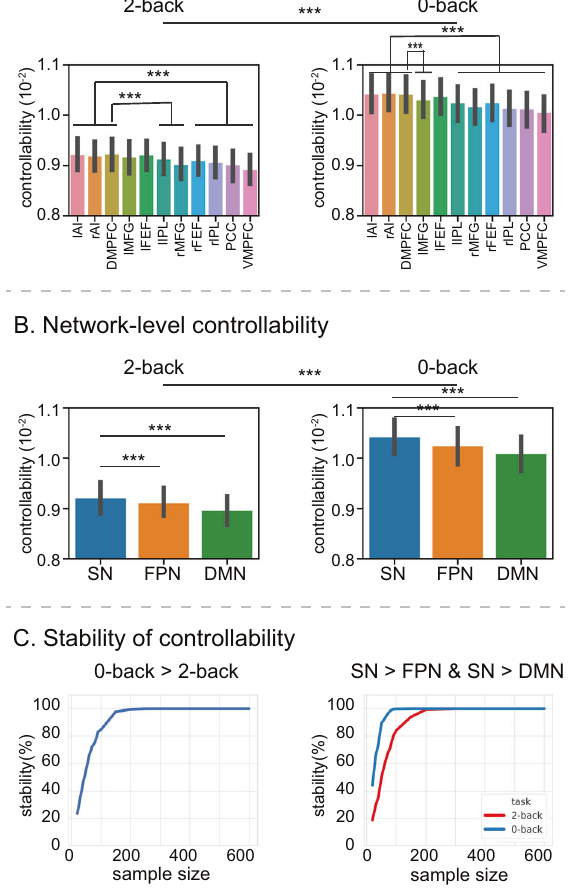
Fig. 7 Working-memory load-dependent functional controllability in SN, FPN, and DMN. A Functional network controllability, assessed in each brain node, was signi fi cantly lower in the 2-back, compared to the 0-back, working-memory task condition ( p < 0.001, two-sided t -test). n = 737 participants. Data are presented as mean ± SEM. AI and DMPFC nodes in the SN have signi fi cantly higher controllability than FPN and DMN nodes, except for lFEF and lMFG nodes of the FPN in the 2-back task condition and lFEF in the 0-back task condition ( p < 0.001, two-sided t -test). n = 737 participants. Data are presented as mean ± SEM. B Functional network controllability, assessed across SN, FPN, and DMN nodes, was signi fi cantly lower in the 2-back, compared to the 0-back, working-memory task condition ( p < 0.001, two-sided t -test). N = 737 participants. Data are presented as mean ± SEM. The SN shows signi fi cantly higher controllability than the FPN ( p = 4.61e − 06, two-side paired t -test) and DMN ( p = 9.84e − 05, two-side paired t -test). N = 737 participants. Data are presented as mean ± SEM. C Stability analyses revealed stable load effect (0-back > 2-back) and network difference (SN > FPN and SN > DMN). X -axis shows sample size, ranging from 20 to 600. Y -axis shows stability, computed as the probability that the load effect of controllability is signi fi cantly different between 2-back and 0- back working-memory conditions, and the probability that the SN shows greater controllability than the FPN and DMN in both 2-back and 0-back working-memory conditions, in random subsamples drawn from N = 737 participants. lAI left anterior insula, rAI right anterior insula, DMPFC dorsomedial prefrontal cortex, lMFG left middle frontal gyrus, rMFG right middle frontal gyrus, lFEF left frontal eye fi eld, rFEF right frontal eye fi eld, lIPL left intraparietal lobule, rIPL right intraparietal lobule, PCC posterior cingulate cortex, VMPFC ventromedial prefrontal cortex. Source data are provided as a Source data fi